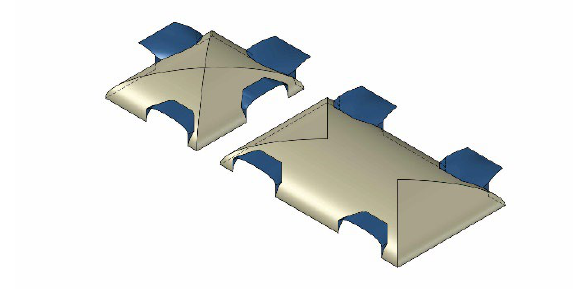
Figure 17. 3D interpretative model of the vault of ‘Camera grande del letto’, room 3 (Modelling: F. Natta)